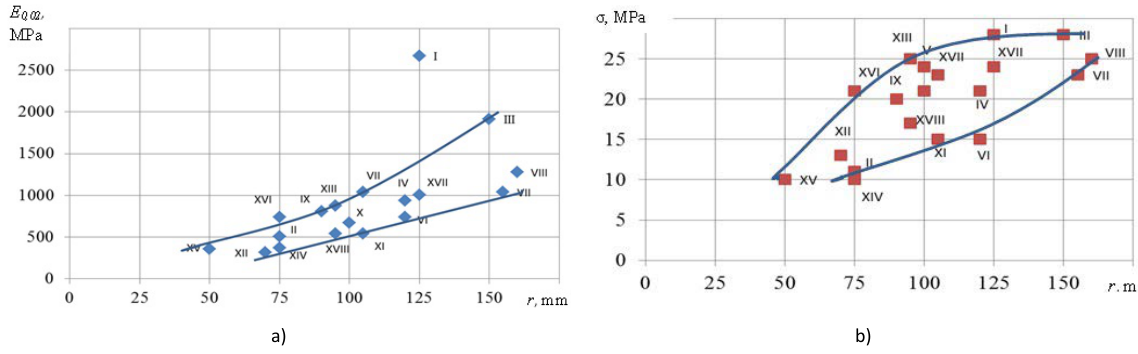
Fig.11 The region for the post-failure rigidity a) and the post-failure structural compressive strength b) for damaged areas of ballistic tested bulletproof